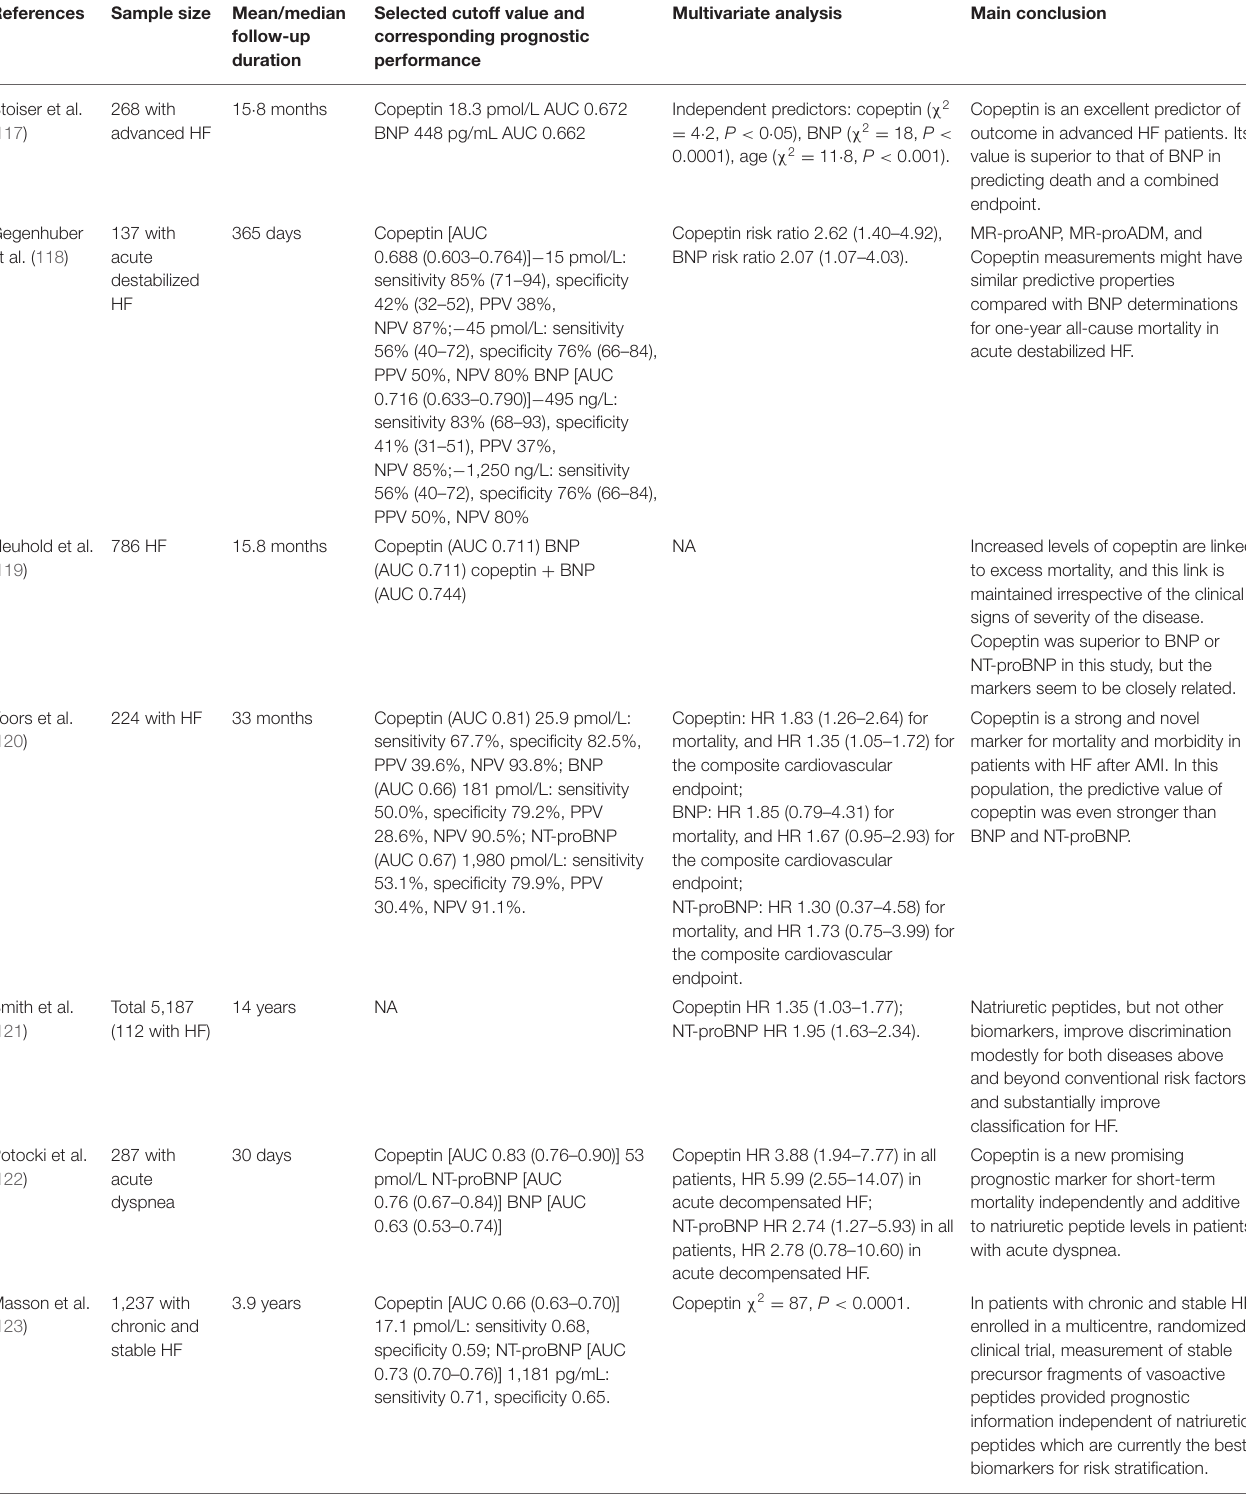
TABLE 4 | Articles about the prognostic value of copeptin (alone or with BNP/NT-proBNP) in predicting the outcome of